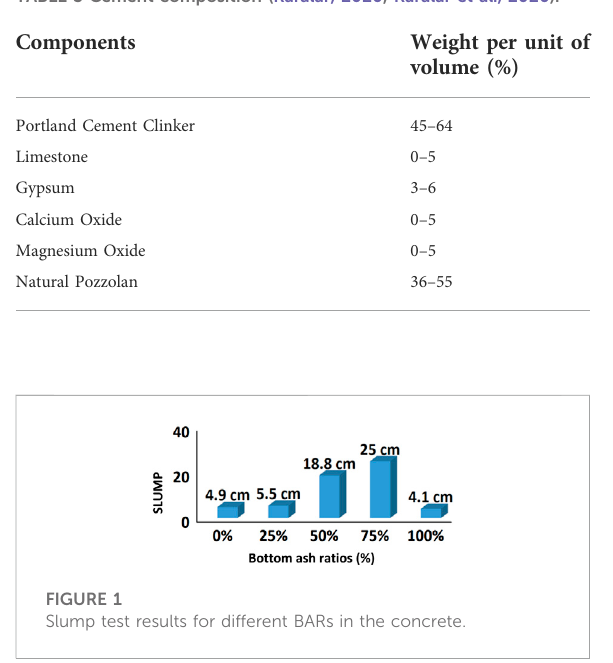
TABLE 3 Cement composition (Karalar, 2020; Karalar et al., 2020).